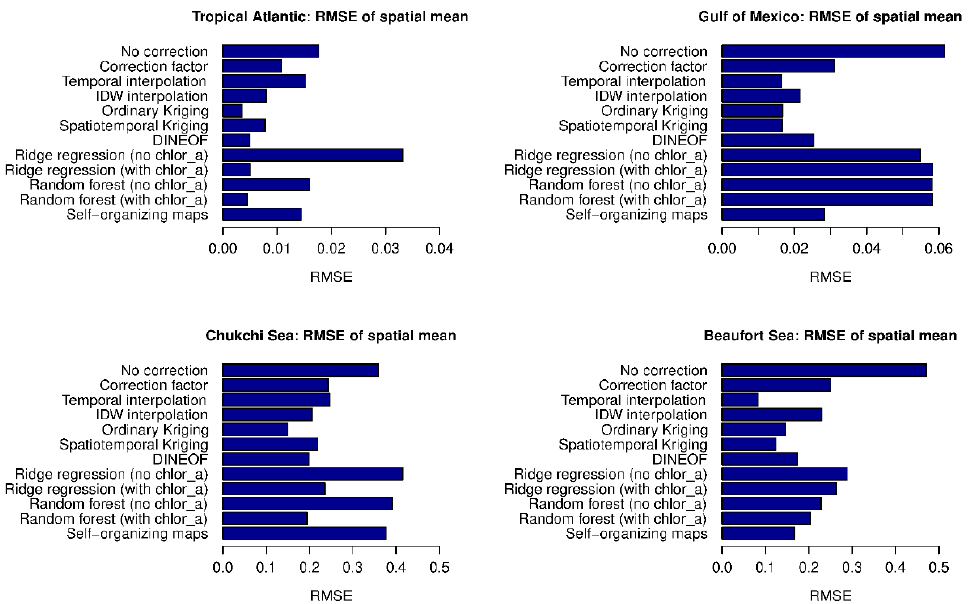
Figure 6. The root mean squared errors (RMSEs) of regional mean Chl a concentrations calculated without prior gap-filling, and after gap-filling using the different algorithms in the four study areas ( 𝑅𝑀𝑆𝐸 𝑚𝑒𝑎𝑛 , Equation (9)).